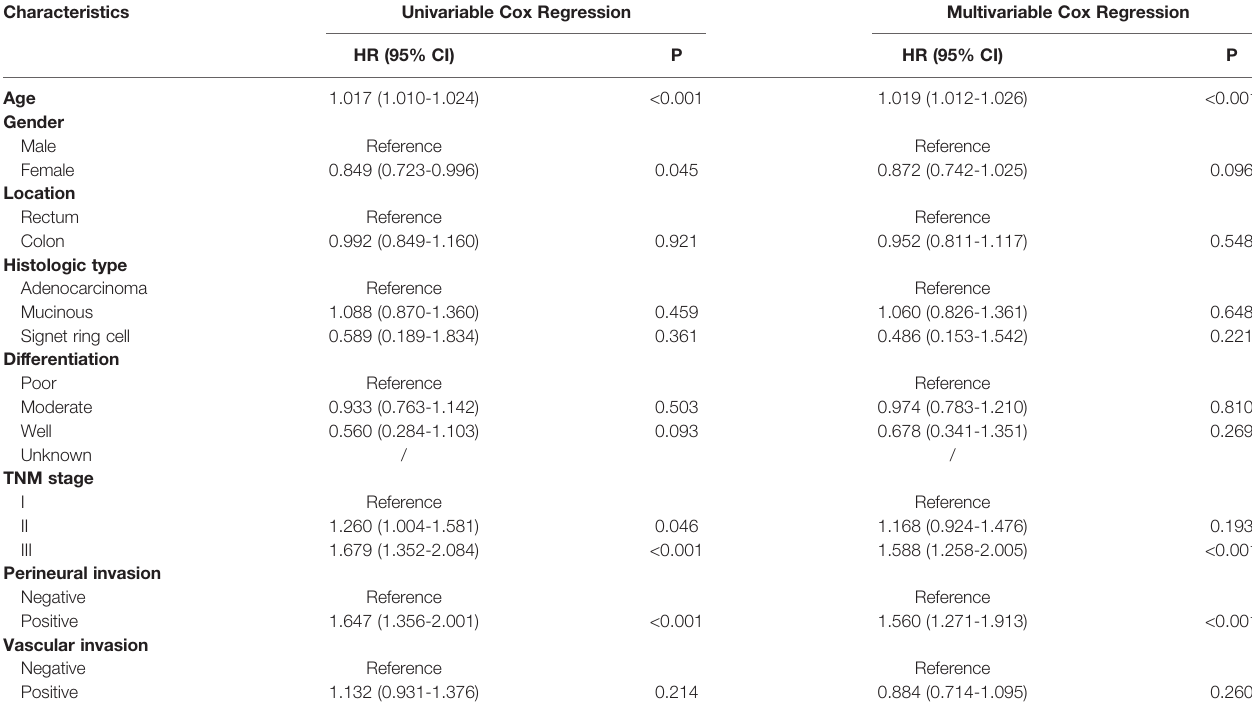
TABLE 4 | Univariable and multivariable Cox regression of disease-free survival in patients who survived over 5 years after surgery. Characteristics